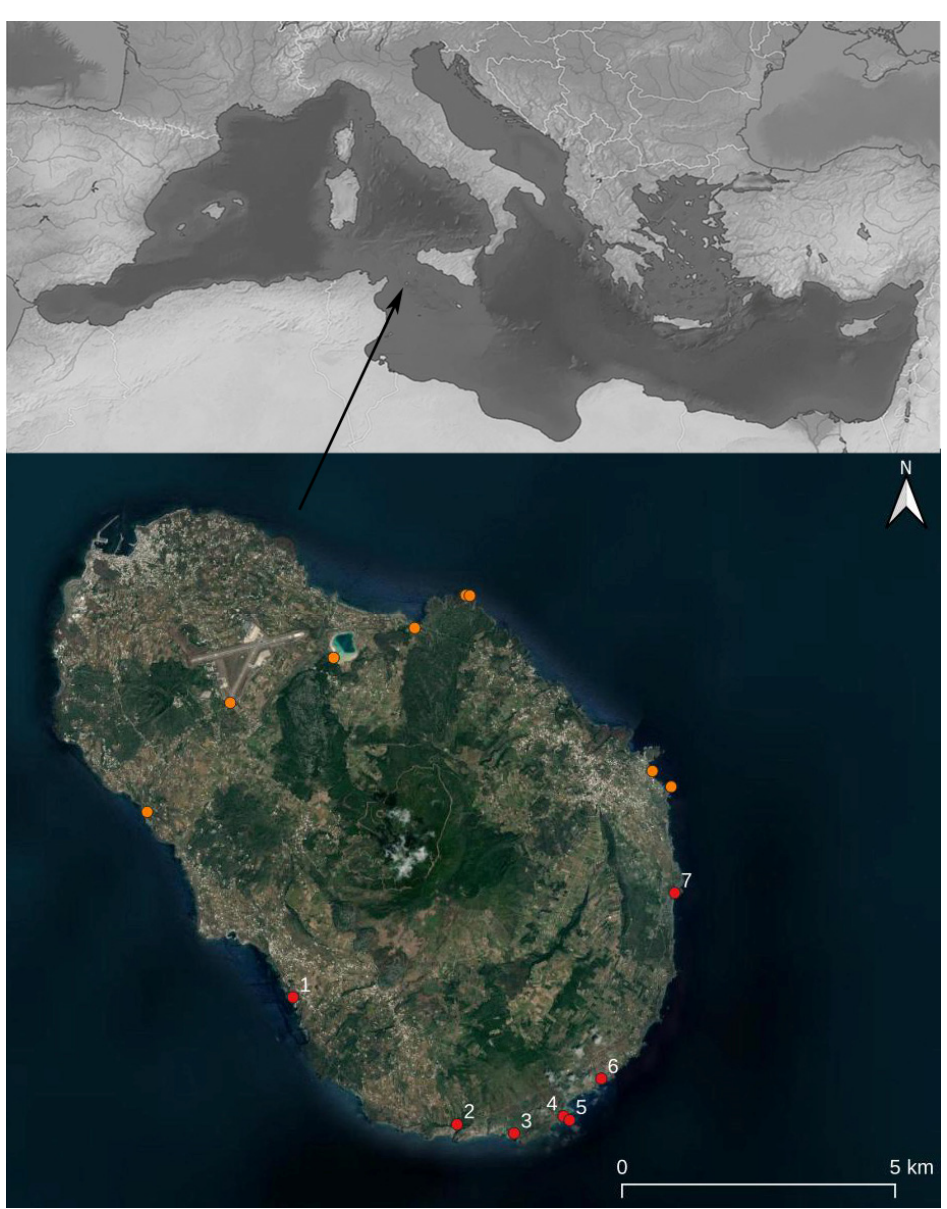
Figure 10. (Above ): Geographical position of the Island of Pantelleria in the Mediterranean. ( Below ): localities of Pantelleria where night recordings have been carried out. Red Dots mark stations where the new species was recorded, and orange dots where it was not recorded. See legend in Table 1.